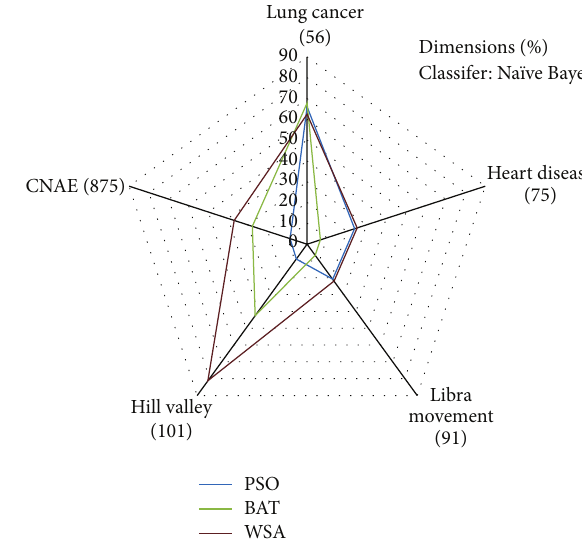
Figure 10: Results in % dimension for Pattern Network are shown visually in radar chart.